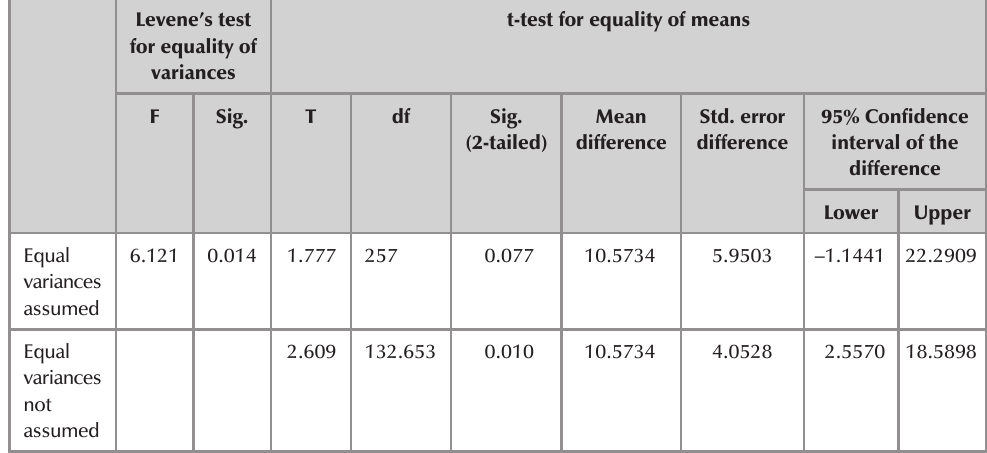
Independent samples test of the residential